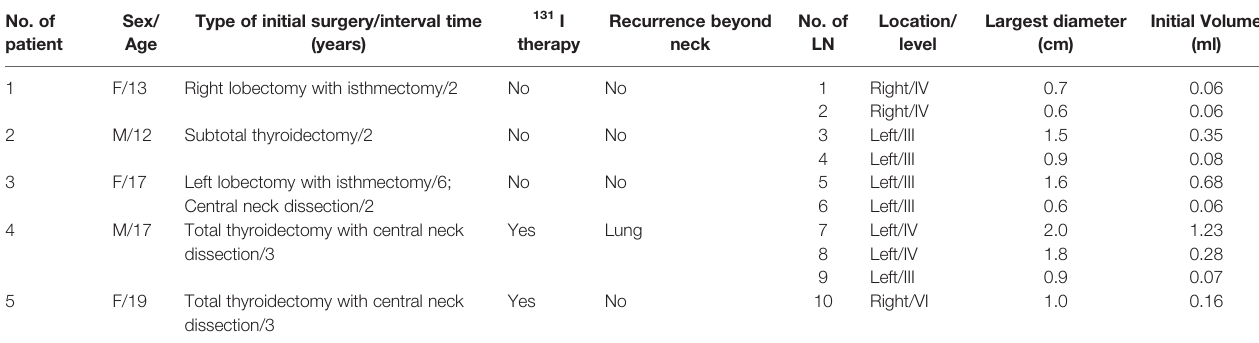
TABLE 1 | The clinical characteristics of the pediatric patients before